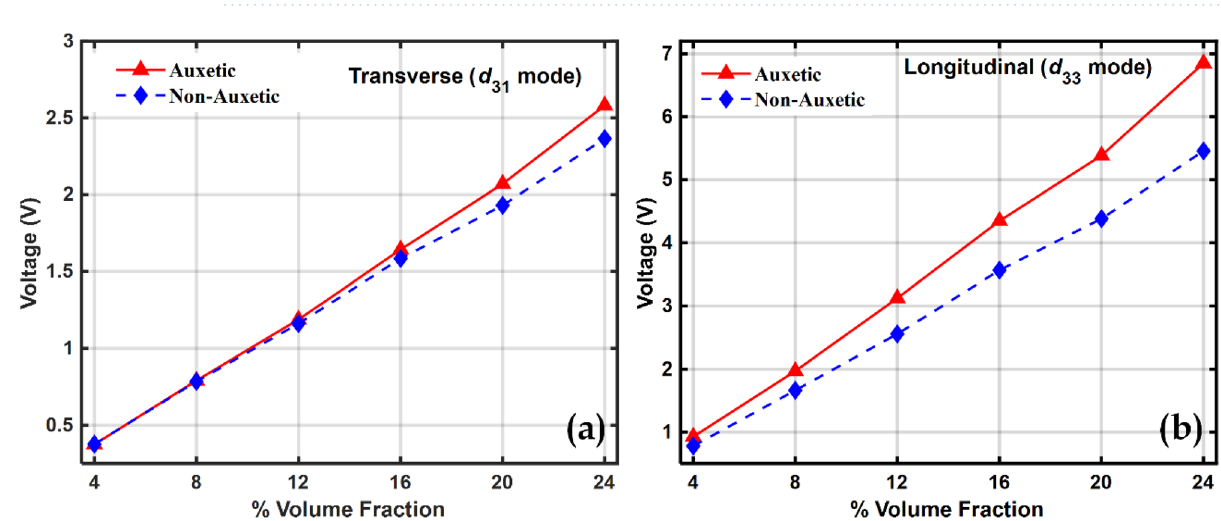
Figure 9. Maximum voltage at different volume fractions of BCZT in ( a ) transverse ( d 31 ) mode and ( b ) longitudinal ( d 33 )